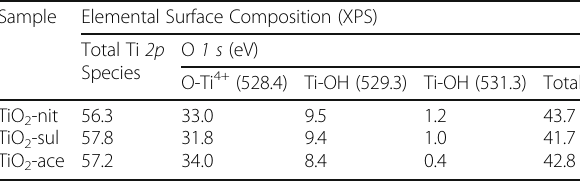
Table 2 Surface Elemental Composition of the Samples From XPS